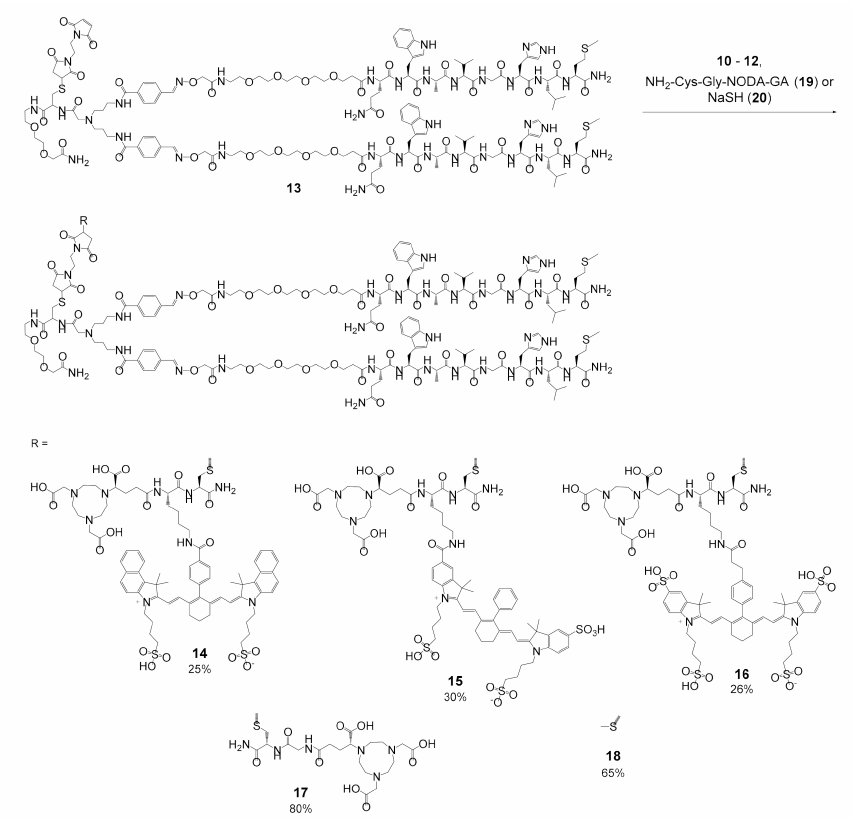
Figure 3. Structuresofthechelator-andNIR-fluorescentdye-modifiedbioconjugates 14 – 16 , thechelator-only analog 17 and 18 , lacking both chelator and NIR